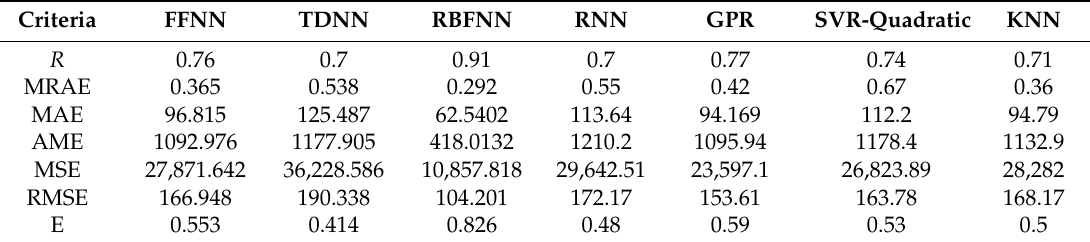
Table 4. Residual criteria for the results of the data training for Dez Basin.